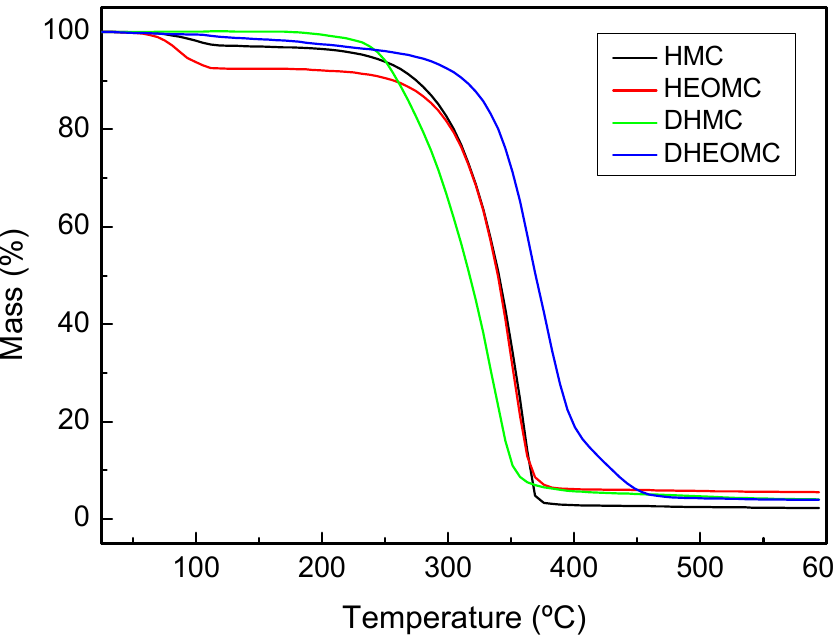
Figure 12. TGA curves for all the coumarin derivatives.